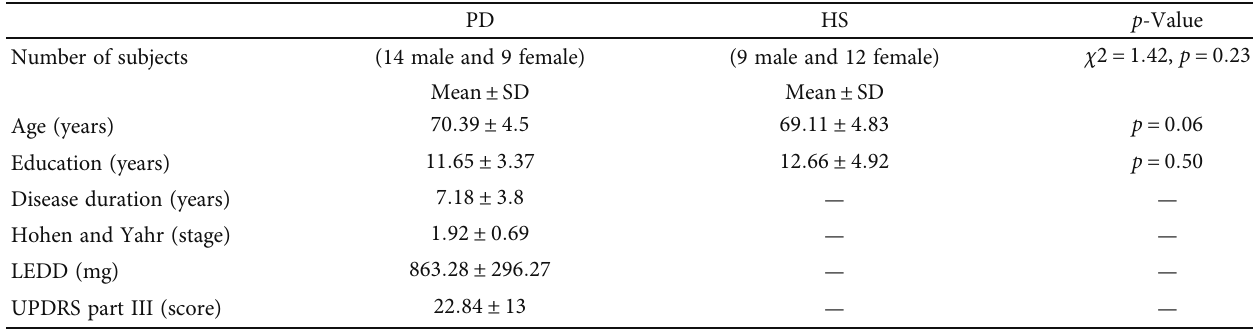
Table 1: Demographic and clinical characteristics.